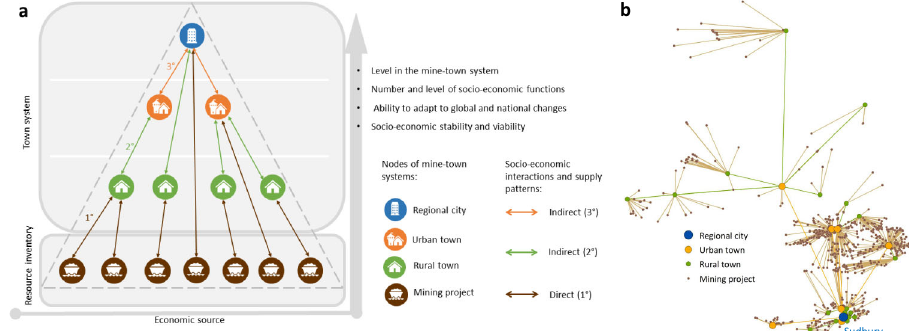
Fig.1|Thearchitectureofamine-townsystem. Wede fi neamine-townsystemas a network of socio-economic connections between resource inventories and town systems. Mining projects and towns serve as ‘ nodes ’ in the mine-town systems. Mining projects are producersinthe systemandrepresentthe resource inventory. The hierarchy of consumers (towns) re fl ects the different size and level of towns